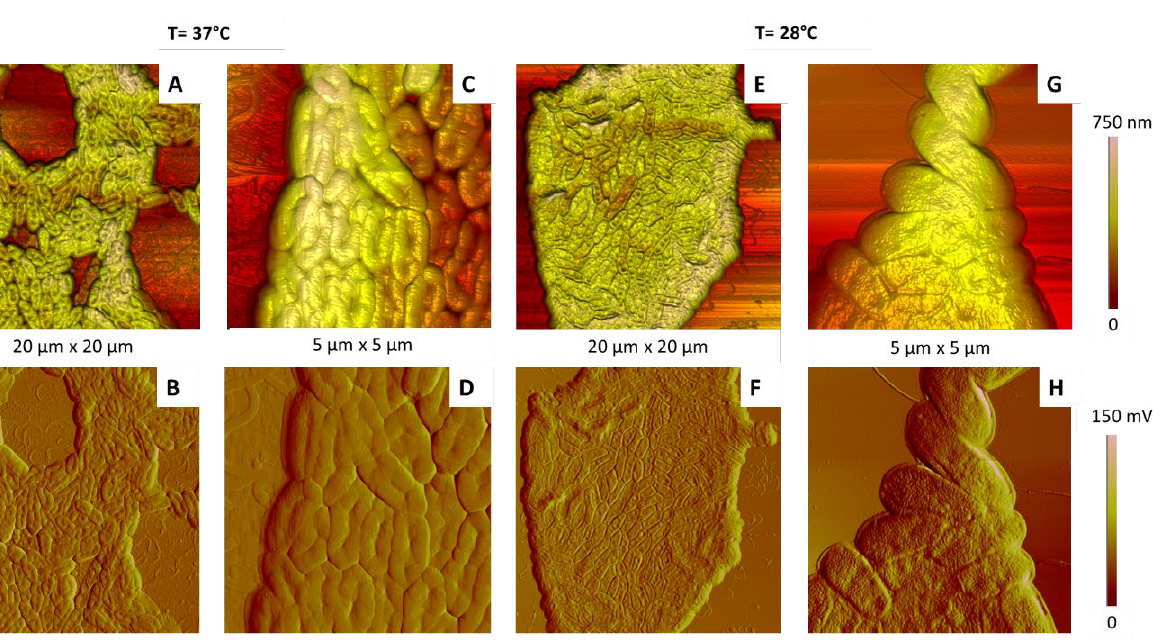
Figure 10. AFM images of P. fluorescens bacteria incubated for 15 h in LB medium at 37 °C ( A – D ) and 28 °C ( E – H ). AFM images are 3D height or topographic ones ( A , C , E , G ) and amplitude ones ( B , D , F , H ).